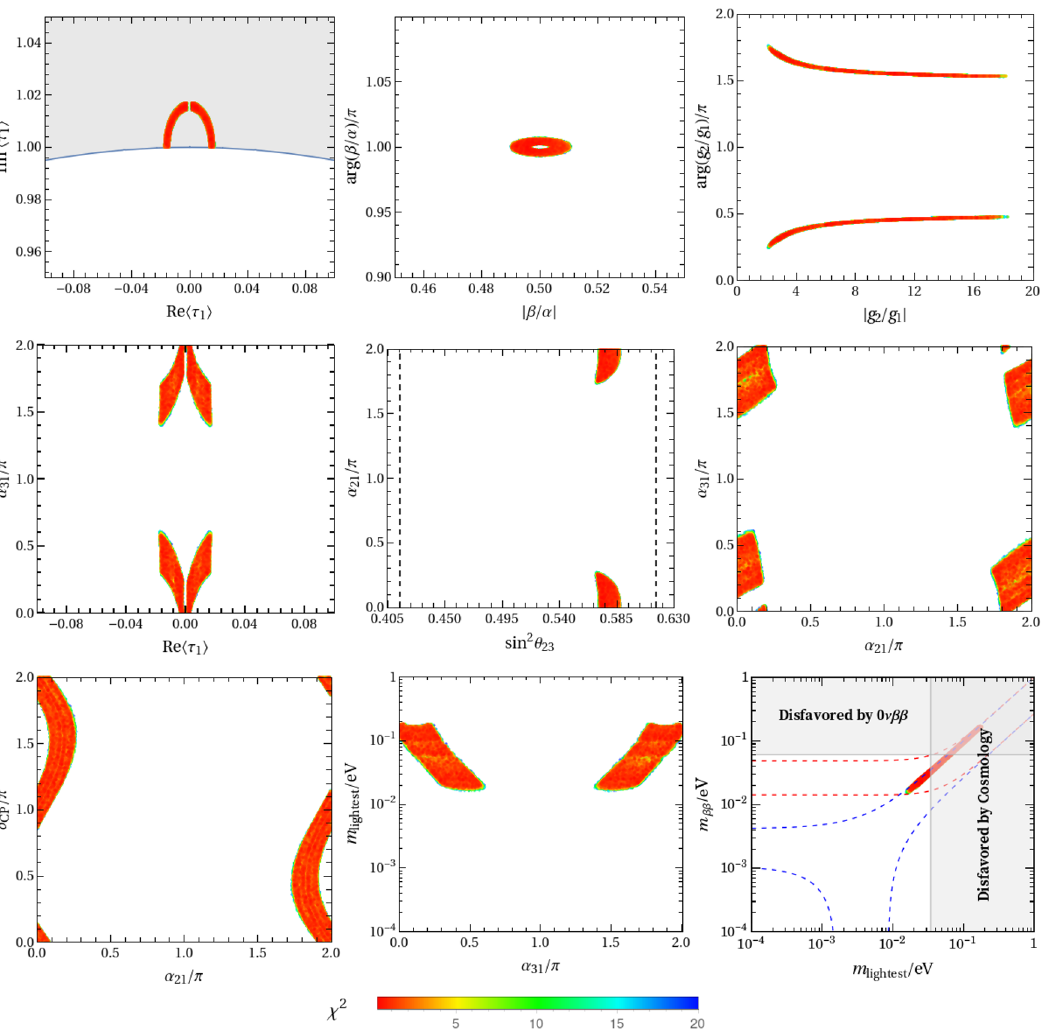
Figure 1 . The predicted correlations among the input free parameters, neutrino mixing angles and CP violating phases in the Model II , where the moduli are restricted to the subspace with τ 1 = τ 2 and τ 3 = 0 . The last panel shows the prediction for the effective Majorana neutrino mass m ββ in neutrinoless double decay. The vertical black dashed lines denote the 3 σ regions of sin 2 θ 23 [81]. The most general allowed regions expected for normal ordering and inverted ordering neutrino masses are indicated by red and blue dashed lines respectively. The horizontal grey band denote the current experimental bound m ββ < (61 ∼ 165) meV from KamLAND-Zen [84], and the vertical grey exclusion band denotes the current bound P m i < 120 meV at 95% confidence level i obtained by the Planck collaboration